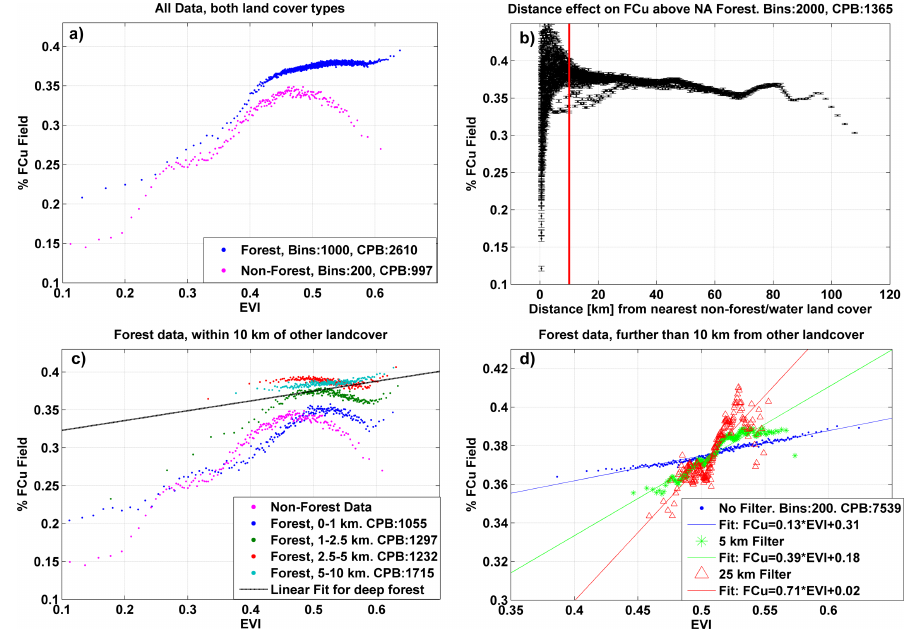
Figure 7. pFCu field as a function of EVI in the NA region (with RH < 80%) during J-A-S, 2011. (a) All data above forest and non-forest land cover types. Counts per bin (CPB) included in panel legend. (b) pFCu field over forest land cover as a function of distance (km) from nearest non-forest/water land cover pixel. Data correspond to NA region (with RH < 80%). (c) Same as (a) but with forest land cover data constrained to within 10km of other land cover types and sorted into 200 bins. The forest data were divided into four distances from other land cover subsets (see legend) to illustrate the transition from a non-forest-like dependence to a deep-forest-like dependence. The black dashed line is the linear fit for deep forest EVI dependence seen in panel (d) . (d) Same as (a) but only for forest land cover data further than 10km from other land cover types. Panel includes raw EVI data (blue) and EVI smoothed with a 5km (red) or 25km (green) disk filter. Linear fits for all cases added in panel legend.